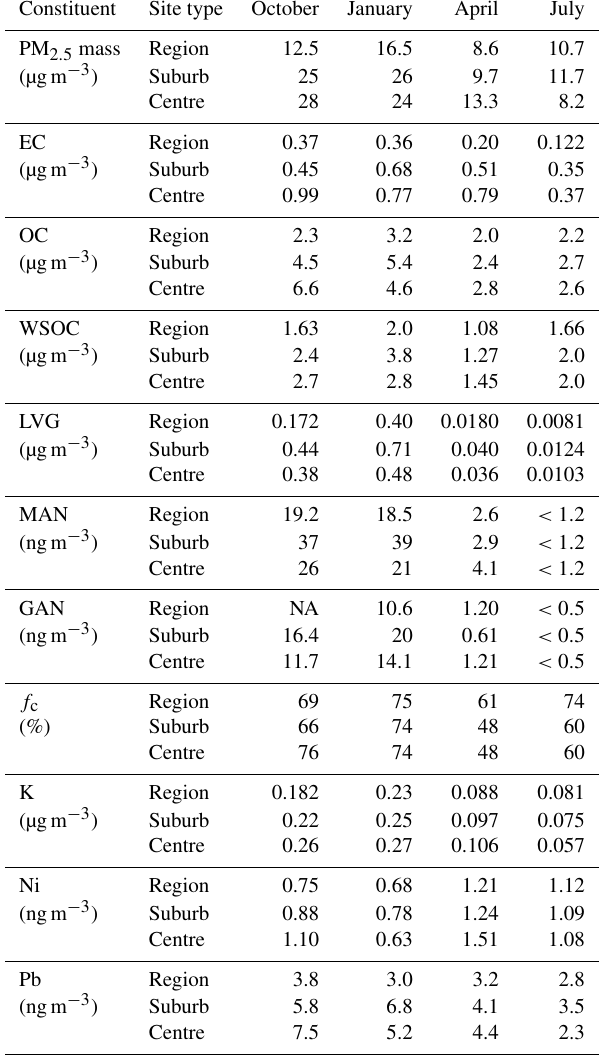
Table 2. Median atmospheric concentrations of PM 2 . 5 mass, ele- mental carbon (EC), organic carbon (OC), water-soluble organic carbon (WSOC), levoglucosan (LVG), mannosan (MAN), galac- tosan (GAN), fraction of contemporary total carbon ( f c ), and me- dian concentrations of K, Ni and Pb for regional background in the Carpathian Basin, suburban area and city centre of Budapest for dif- ferent months representing different